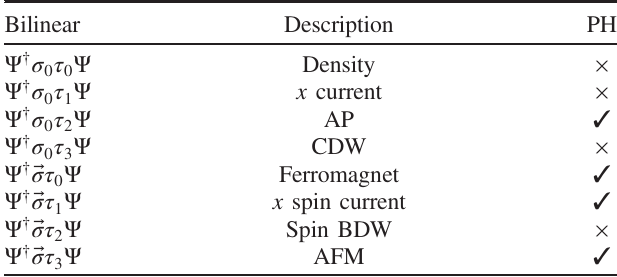
TABLE VI. Symmetry of the particle-hole channel fermion bilinears listed in Table II under particle-hole (PH) transformation [Eqs. (C2) and